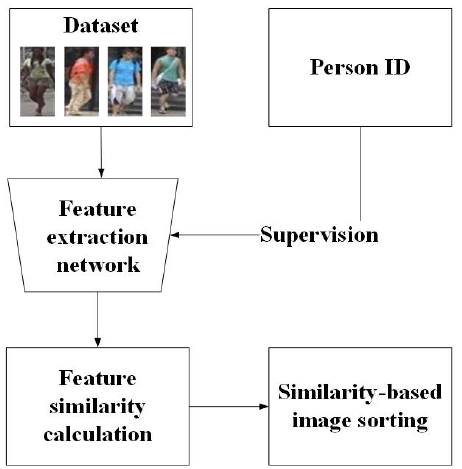
Figure 2. The general process of supervised person